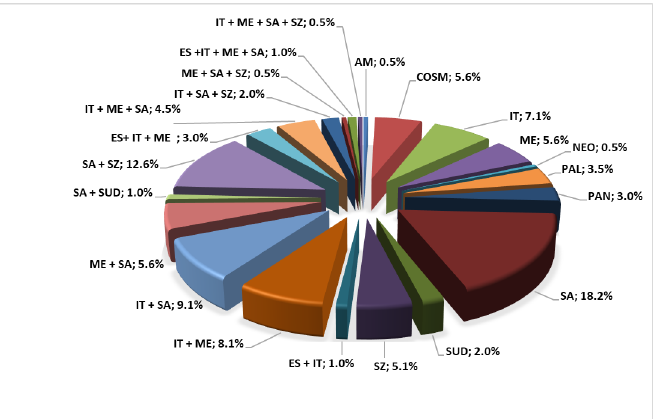
Figure 6. Floristic regions and chorotypes from the recorded taxa in Jabal Al-Ward. Note: American (AM), Cosmopolitan (COSM), Euro-Siberian (ES), Irano-Turanian (IT), Mediterranean (ME), Neotropical (NEO), Paleotropical (PAL), Pantropical (PAN), Saharo-Arabian (SA), Sudano-Zambesian (SZ), and Sudanian (SUD). Table 3. The number of the recorded taxa belonging to the main floristic categories and their relevant percentages (%) in Jabal Al-Ward. American (AM), Cosmopolitan (COSM), Euro-Siberian (ES), Irano-Turanian (IT), Mediterranean (ME), Neotropical (NEO), Paleotropical (PAL), Pantropical (PAN), Saharo-Arabian (SA), Sudano-Zambesian (SZ), and Sudanian (SUD). Chorotype Number of Species Percentage (%) Mono-Regional AM